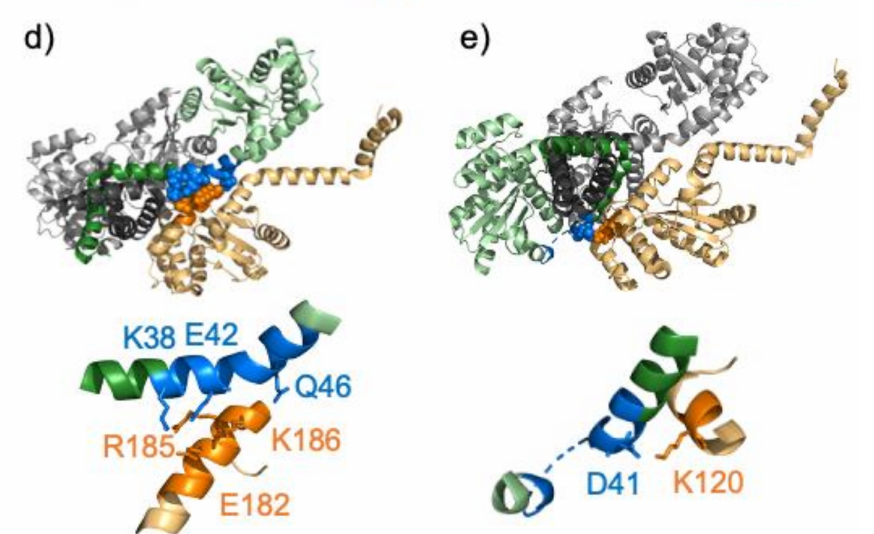
Figure 1. Crystal structures of the PmScsC trimer show several different relative orientations of the trimerization stalk and the catalytic domains and different conformations for the eleven-residue linker peptide. The three molecules which form the trimer are shown in grey with the trimerization stalk shown in a darker grey. Contacts between molecules involving residues within the linker peptide region are shown in the full protein structures and in zoomed-in expansions with important residues shown as spheres and sticks, respectively. ( a ) The extended crystal structure (5id4). The linker peptide sequence is shown in blue in molecule A. Lys 38 and Lys39 make contacts to Glu 26 and Glu 29 in molecule B which are shown in red. ( b ) The compact crystal structure (4xvw). Molecules A, B and F are shown. The linker peptide sequence is shown in blue in molecule A. Asp 41 and Gln 44, shown in blue, make contacts to Lys 120 and Asn 152 in molecule F, shown in red. ( c – e ) The transitional crystal structure (5idr). Molecules A, B and C which form a trimer are shown; for clarity, molecules A, B or C are shown in pale green (with the trimerization stalk shown in dark green) in panels d, c or e, respectively. Molecule D from a neighbouring trimer is shown in yellow. In panel c the linker peptide sequence in molecule B is shown in blue and residues 25–44 and 200–217 in molecule A, with which it makes intermolecular contacts, are shown in red. Hydrogen bonds are formed between Gln 44 and Arg 48 on molecule B and Gln 36 and Glu 217 in molecule A. In panel d the linker peptide sequence in molecule A is shown in blue with Lys 38, Glu 42 and Gln 46 highlighted. These three residues make hydrogen bonds to Glu 182, Arg 185 and Lys 186 in molecule D which are shown in orange. In panel e the linker peptide sequence in molecule C is shown in blue and residues 117–120 in molecule D with which it makes intermolecular contacts are shown in orange. There is a salt bridge between Asp 41 in chain C and Lys 120 in molecule D. Note that the coordinates of residues 46–47 are missing from chain